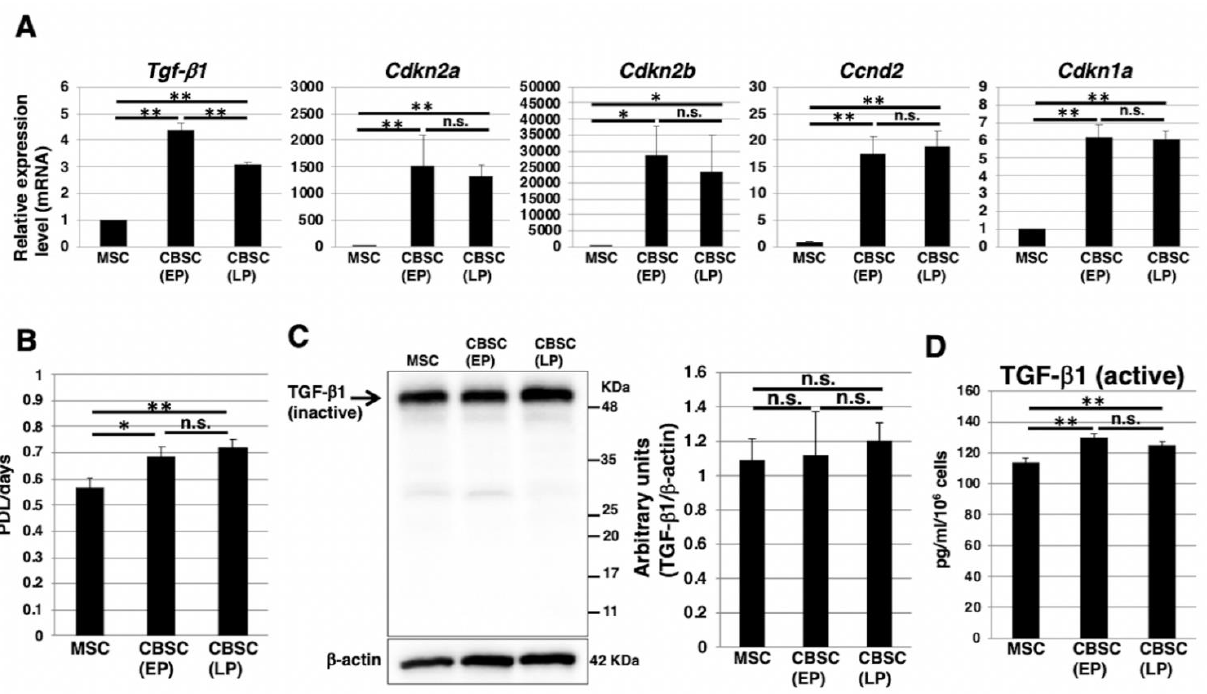
Figure 5. The cell cycle feature and TGF- β 1 expression in mCBSCs. ( A ) Real-time PCR analysis of Tgf- β 1 , Cdkn2a , Cdkn2b , Ccnd2, and Cdkn1a in mMSCs and mCBSCs (EP and LP). The results are shown after normalization against the values obtained for mMSCs (value = 1). The values shown are the means ± SD from three independent experiments. * p < 0.05; ** p < 0.01. ( B ) Growth rate in mMSCs and mCBSCs (EP and LP) is shown by PDL/days. Data are expressed as mean ± SD from three independent experiments. * p < 0.05; ** p < 0.01. ( C ) Western blot analysis of TGF- β 1 and β -actin (loading control) in mMSCs and mCBSCs (EP and LP). The blot images were cropped to highlight the β -actin bands. The histogram shows the mean densitometric analysis ± SD of TGF- β 1 normalized to the loading control ( β -actin). The values were obtained from three independent experiments. n.s.: not significant. ( D ) Cell culture supernatant from mMSCs and mCBSCs (EP and LP) was subjected to ELISA detection for TGF- β 1 levels. The values shown are the means ± SD from triplicate measurements. ** p < 0.01, n.s.: not significant. Abbreviations: mMSC, mouse mesenchymal stem cell; mCBSC, mouse cortical-bone-derived stem cell; EP, early passage; LP, late passage; PDL, population doubling level.